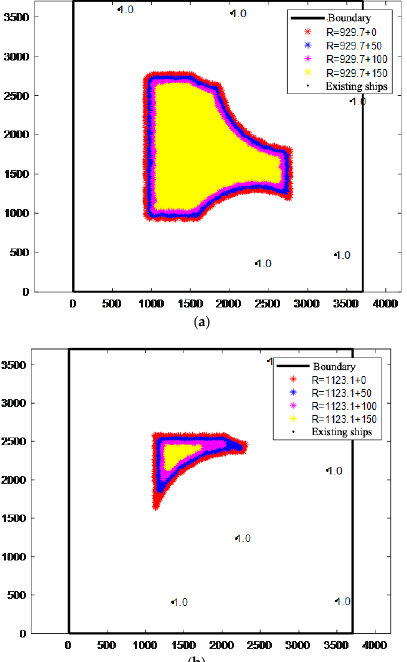
Figure 9. Schematic diagram of mooring area detection with wind force ≤ 7 and water depth of 20 m. ( a ) Represents 192 m and 192 m ship type mooring area detection. ( b ) Represents 333 m and 333 m ship type mooring area detection.